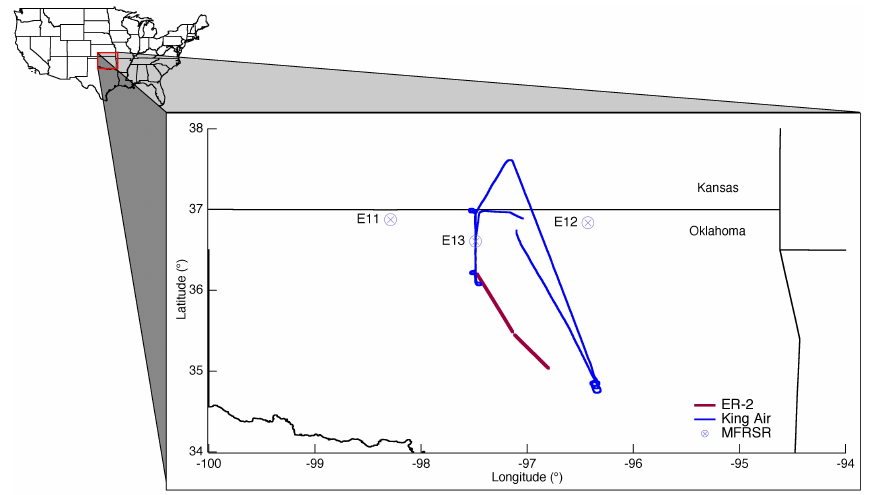
Fig. 1. The general map of aircraft flight tracks with locations of three MFRSRs (circles), and representative flight patterns flown by the ER-2 (red) and the King Air (blue) on 12 June 2007. The corresponding AOD values for these flight patterns are shown in Fig. 9 (Sect. 4).